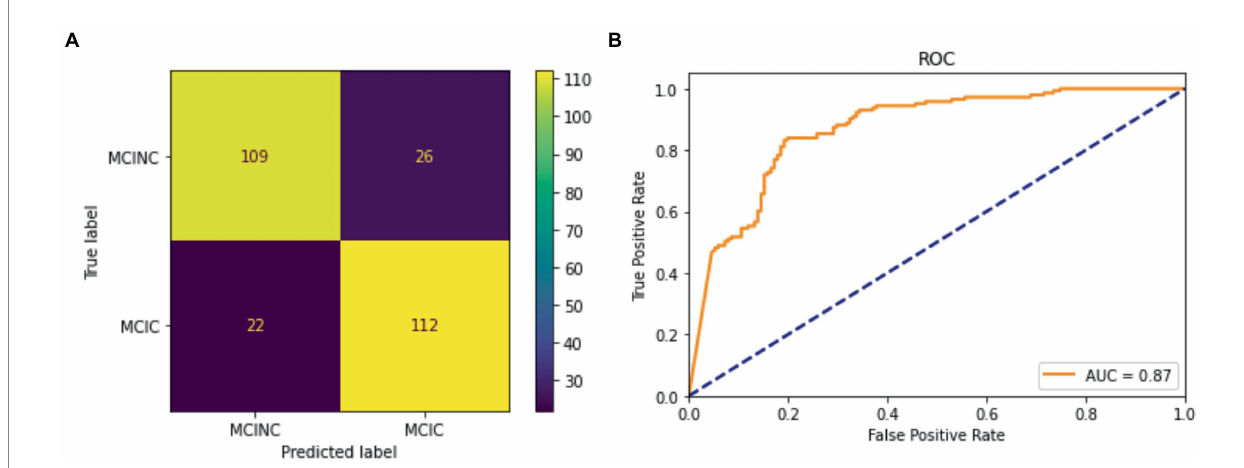
FIGURE 5 Classification result for the proposed model for MCINC and MCIC class. (A) Confusion matrix of the test dataset. (B) ROC curve (receiver operating characteristic curve).